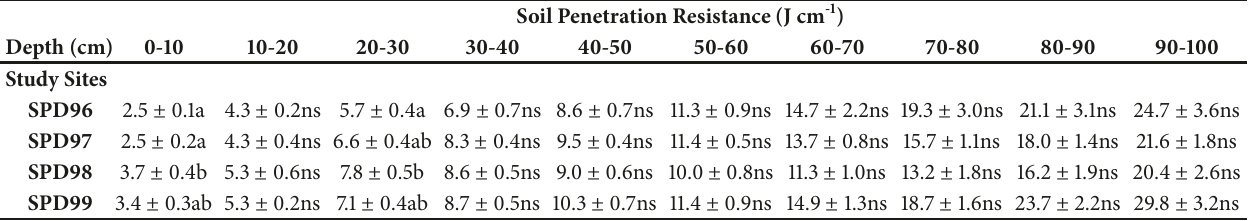
Figure 4: Boxplots: average total height and diameter at breast height of planted S. macrophylla in SPD96, SPD97, SPD98, and SPD99 display individualdatapoints.Theboxplots(boxandwhiskerillustrations)displaydataonvaluesofminimum,maximum,firstquartile,thirdquartile, interquartile range, and median as shown in the figure above. x: mean value; n: number of survived trees. Table 3: Comparison of soil penetration resistance at 0-100 cm depth in plot aged 20 years (SPD96), plot aged 19 years (SPD97), plot aged 18 years (SPD98), and plot aged 17 years